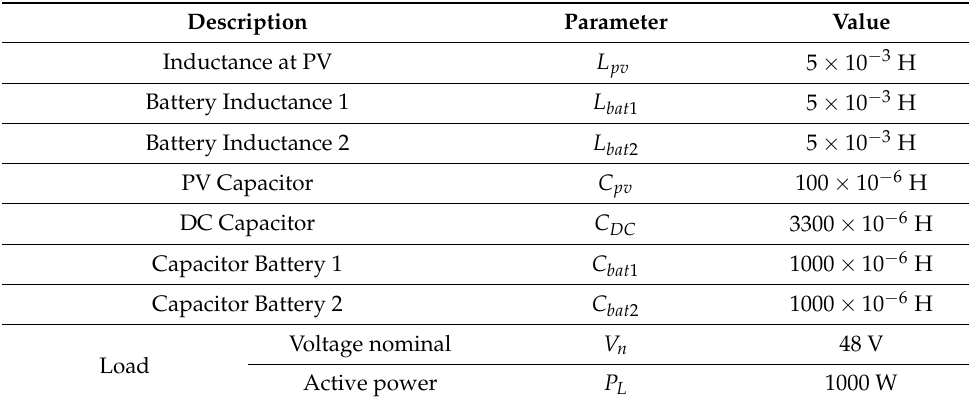
Table 3. Characteristics of the